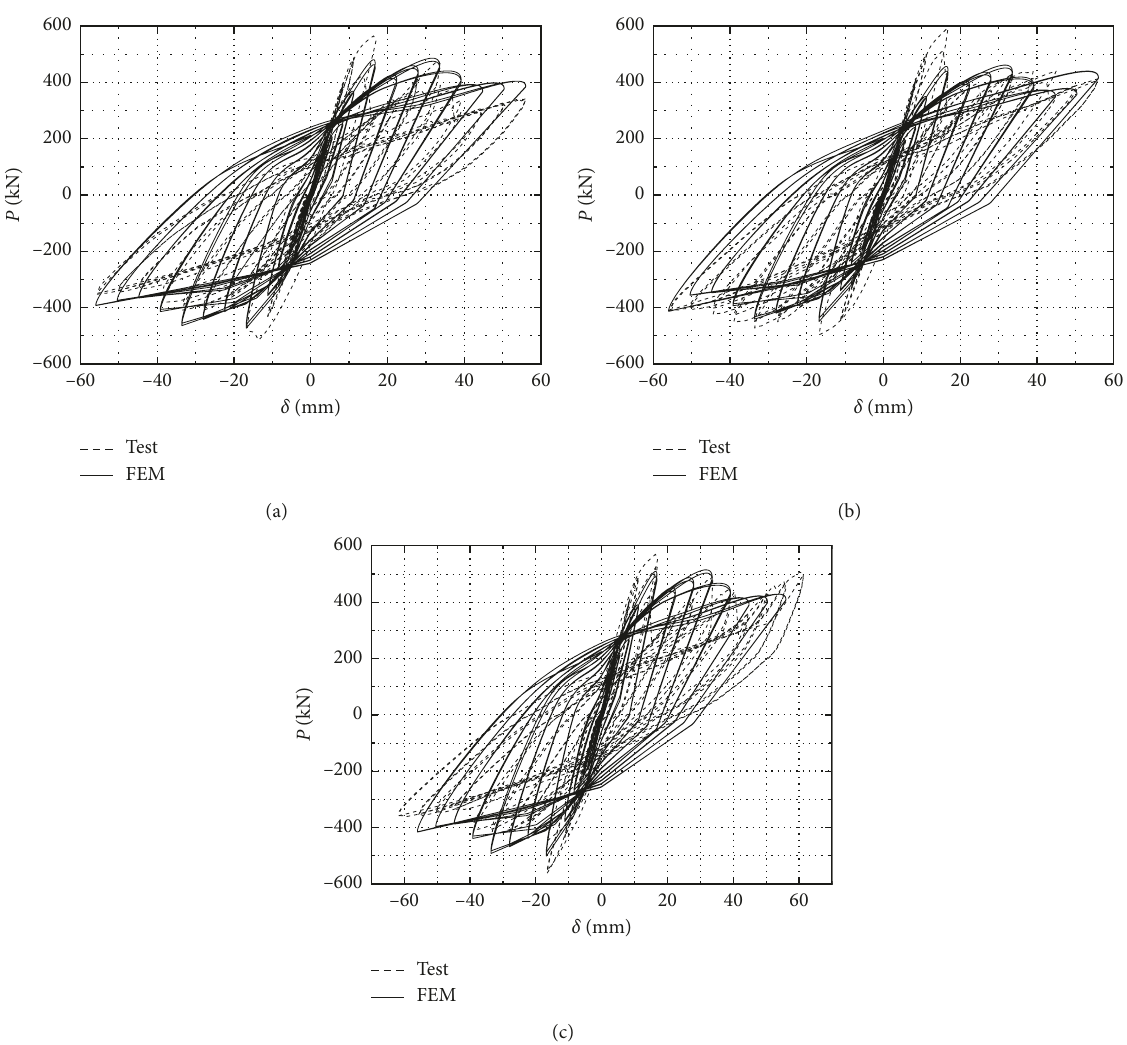
Figure 12: Hysteresis curve comparison of the specimens. (a) Hysteresis curve comparison of the specimen C-JA. (b) Hysteresis curve comparison of the specimen C-JB. (c) Hysteresis curve comparison of the specimen C-JC.